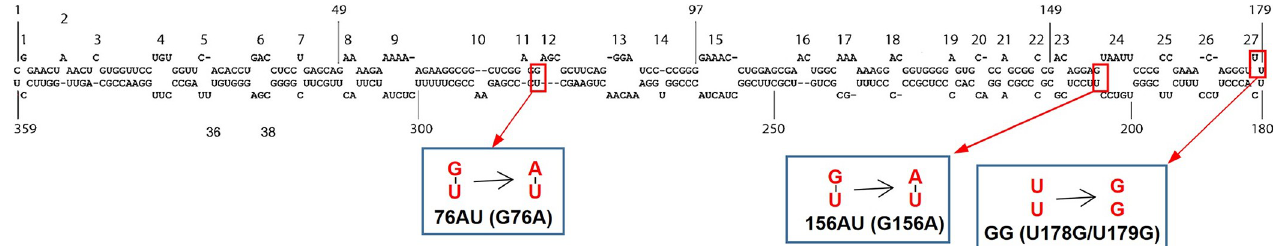
Fig 1. Locations of the PSTVd GG, 76AU, and 156AU mutants. PSTVd mutations U178G/U179G (GG), G76A (76AU), and G156A (156AU) are highlighted on the secondary structure of PSTVd. Loops/bulges in the circular 359 nt genomic RNA are numbered 1 through 27.